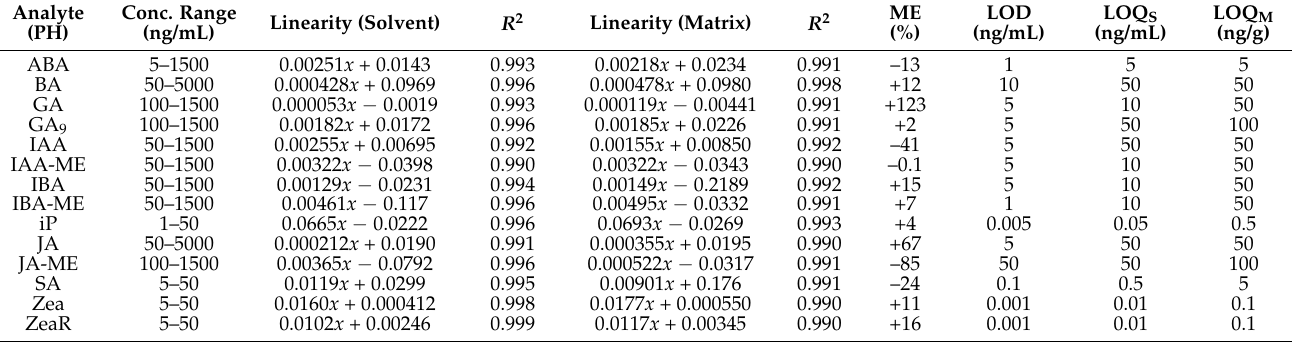
Table 2. Method validation parameters of 14 target phytohormones (PH): concentration range (ng/mL) used for linearity determined both in solvent (methanol: H 2 O, 70:30, v / v ) and in 1-year-old Pinus pinaster stem matrix, matrix effects (%), limit of detection (LOD), limit of quantification in solvent (LOQ S ) and in matrix (LOQ M ). For analyte abbreviations see Supplementary Table